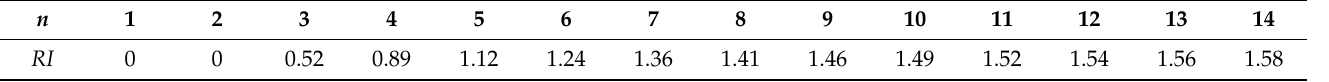
Table 12. Average random consistency